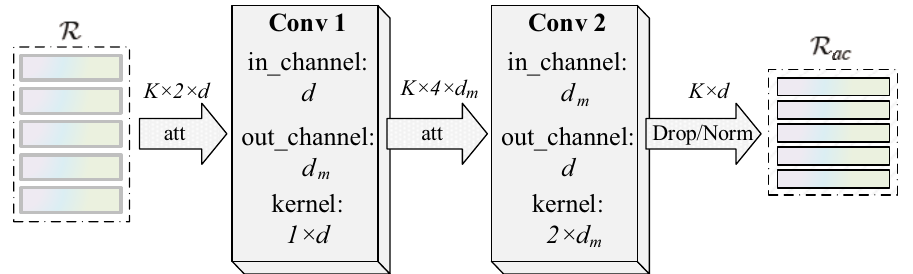
Figure 2. Attention convolution layer for computing relation prototypes.